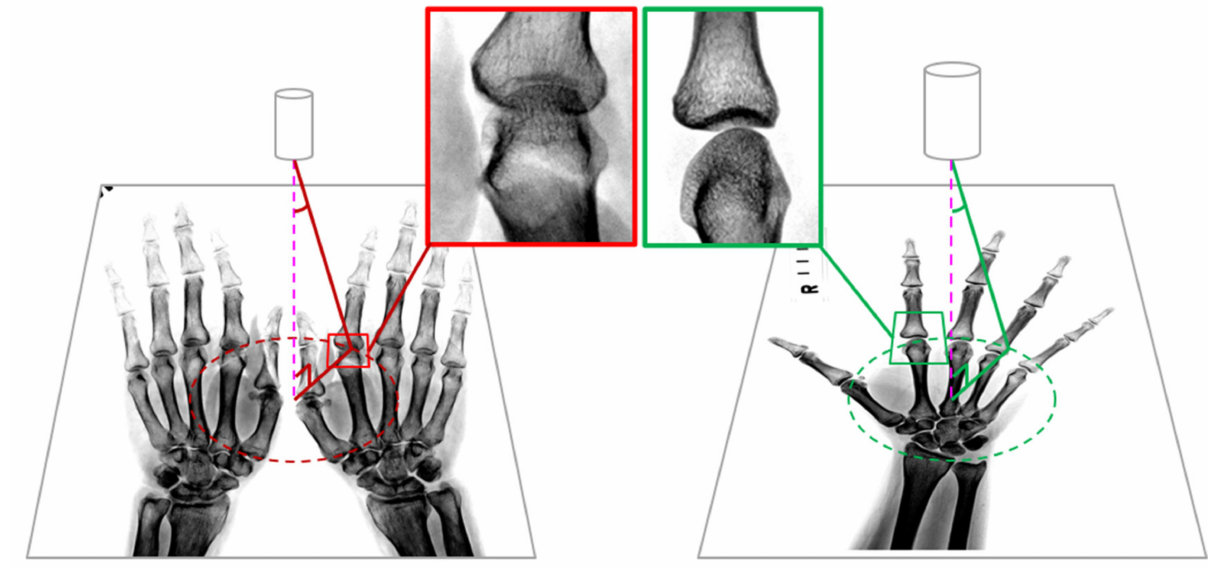
Figure 8. Comparison between the different projection angles from two-hand and one-hand X-ray imaging protocols: (left) two-hand X-ray; (right) one-hand